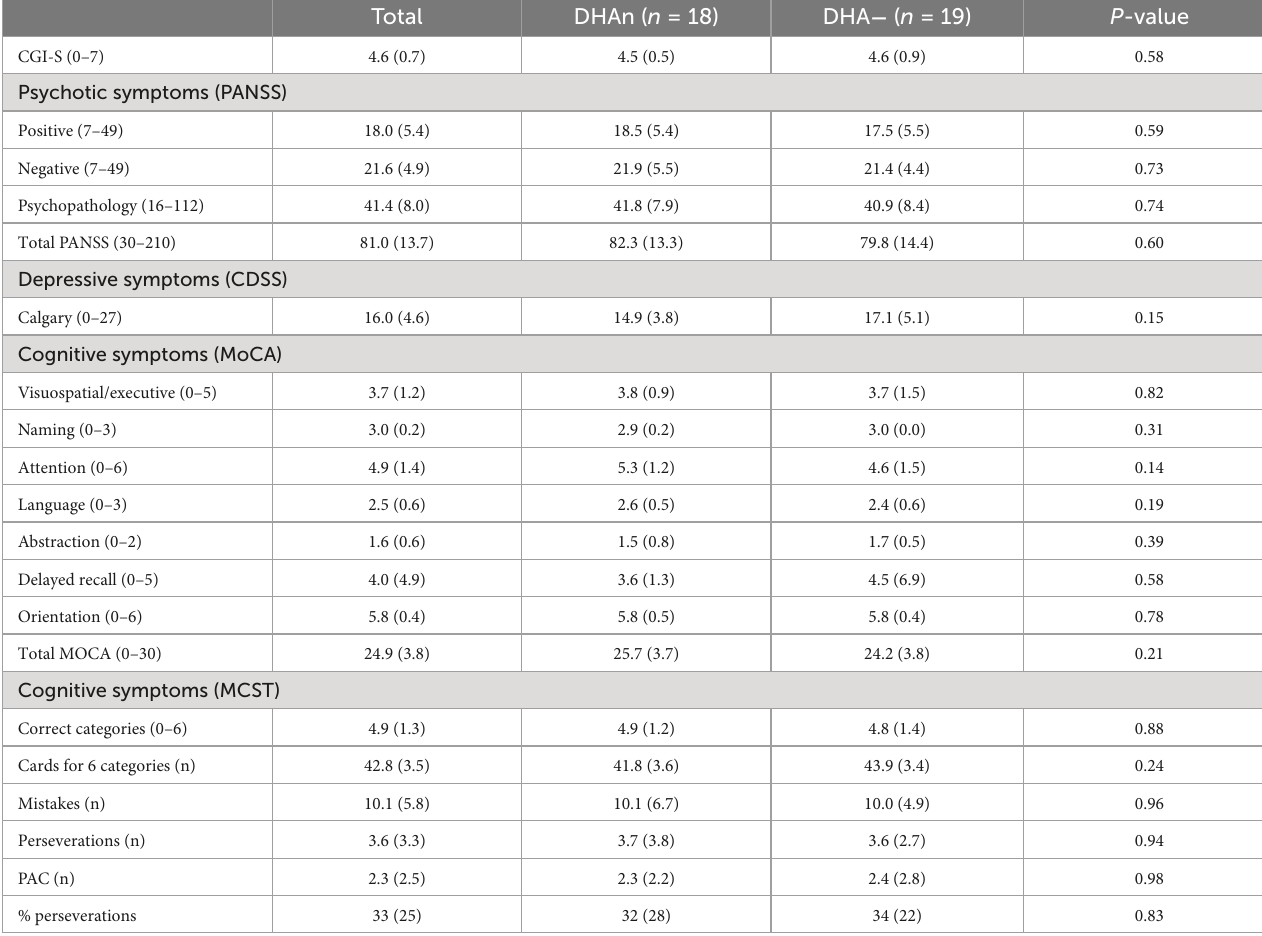
TABLE 4 Results on the neuropsychiatric symptoms comparing the two